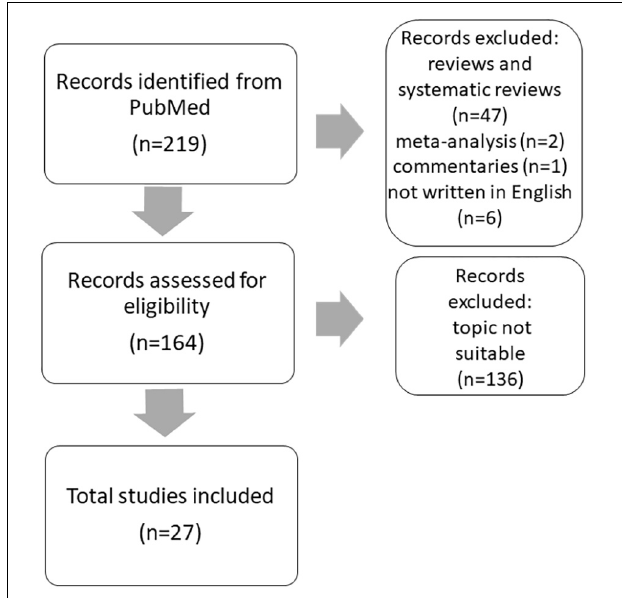
FIGURE 1 | Article